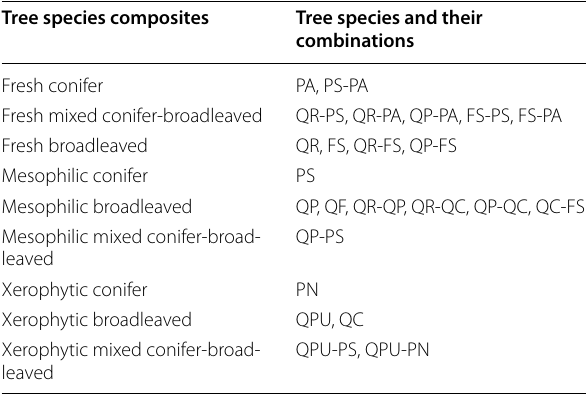
Table 2 Classification of tree species and groups of tree species into composites based on the basic species characteristics, e.g., of being mesophilic, xerophytic, thermophilic, or cold tolerant.